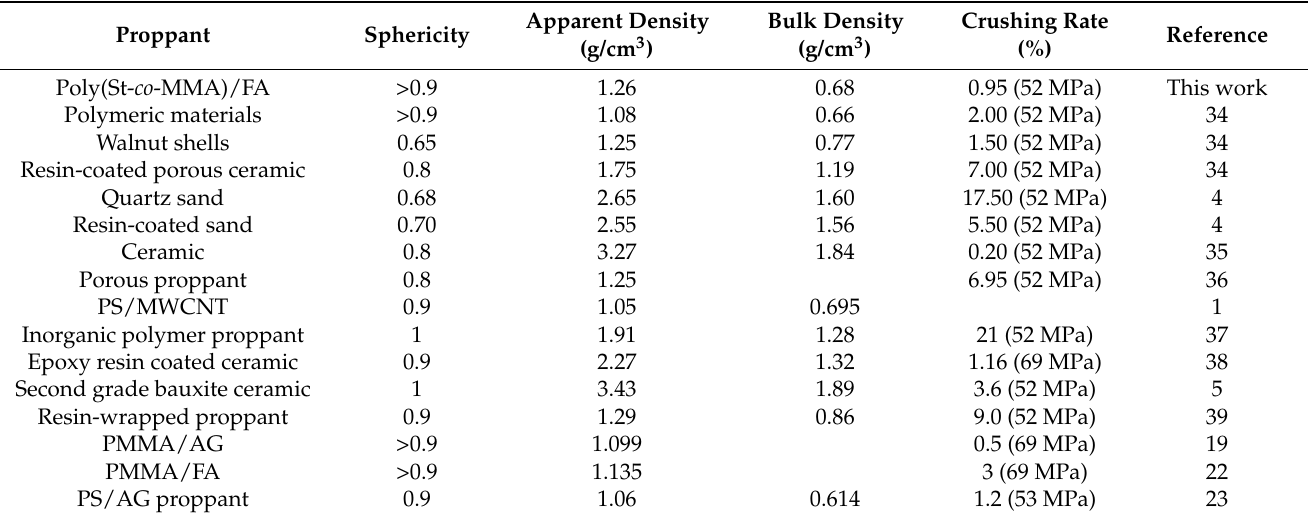
Table 1. Comparison of different types of